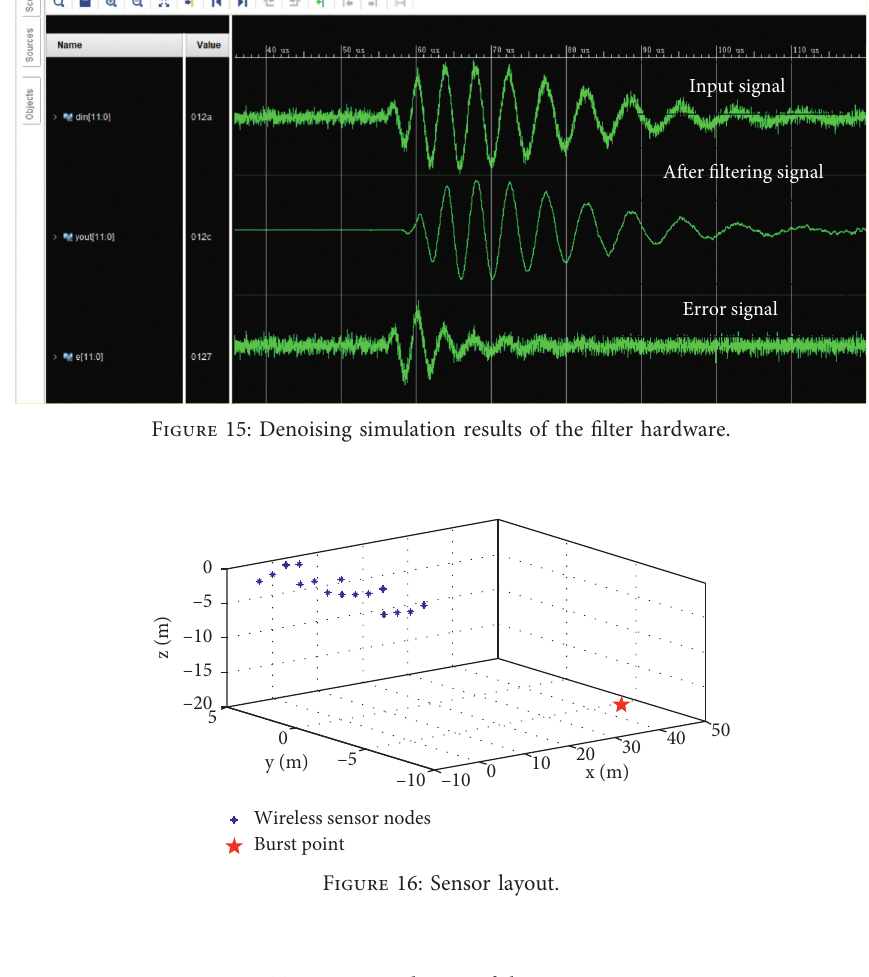
Table 3: Coordinates of the sensors.